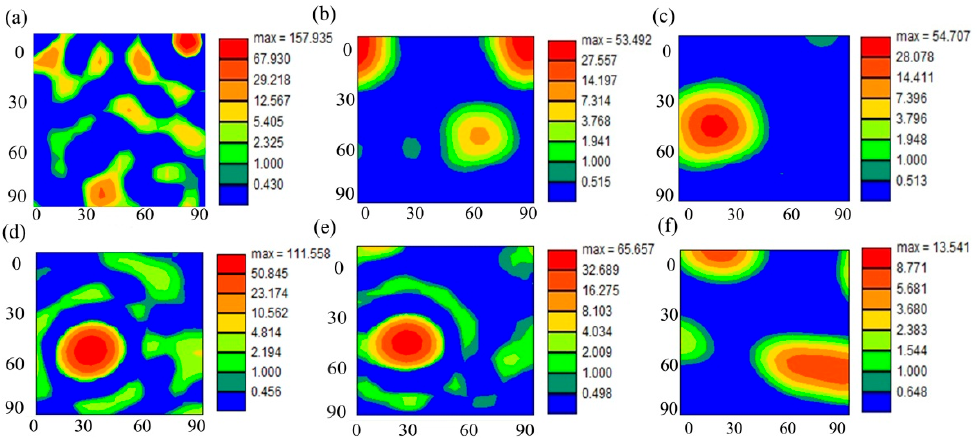
Figure 9. B 2 phase orientation distribution function (ODF) figures of the as-rolled and can-compressed Ti 2 AlNb samples subject to annealing treatment: ( a ) as-rolled, ( b ) 25%, ( c ) 50%, ( d ) 60%, ( e ) 65%, and ( f ) 75%.